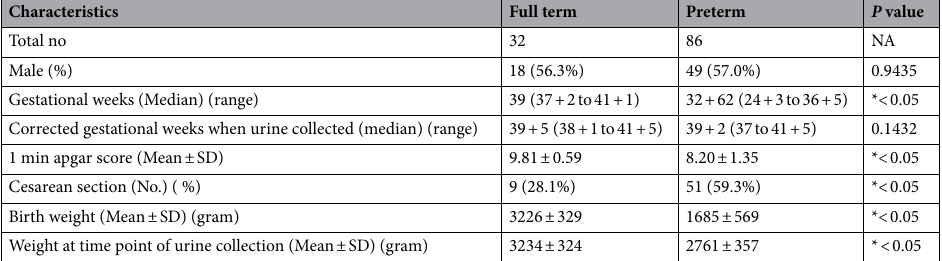
Table 1. Characteristics of the full term and preterm infants. P value < 0.05 was considered statistically significant. Statistically significant differences are shown by asterisks. NA: Not